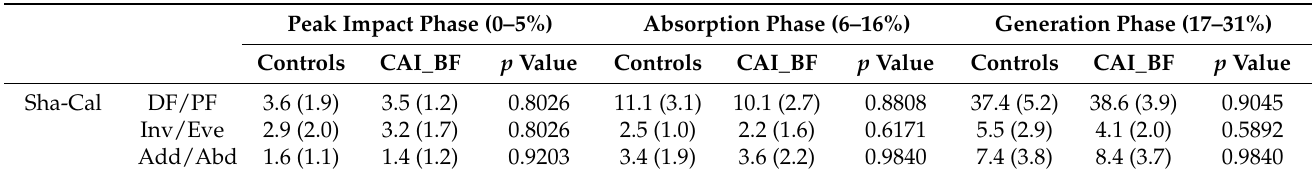
Table 2. Summary of mean range of motion and standard deviation (in degrees) during three subphases of stance while running in controls versus